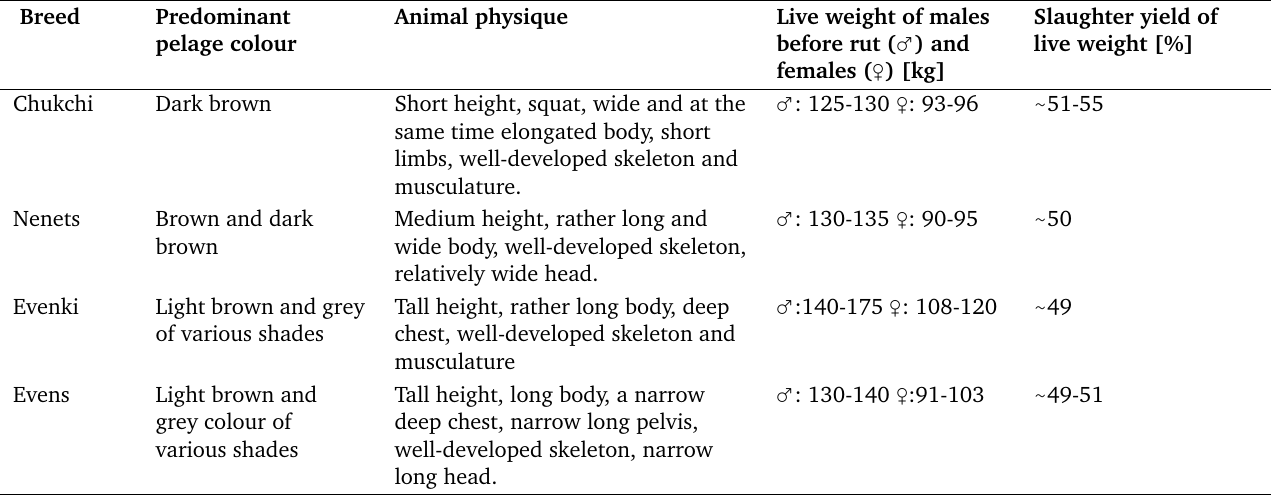
Table 1. Comparative characteristics of four domestic breeds of reindeer in Russia. Characteristics were summarized from our observations and FAO data (Zabrodin and Borozdin, 1989).